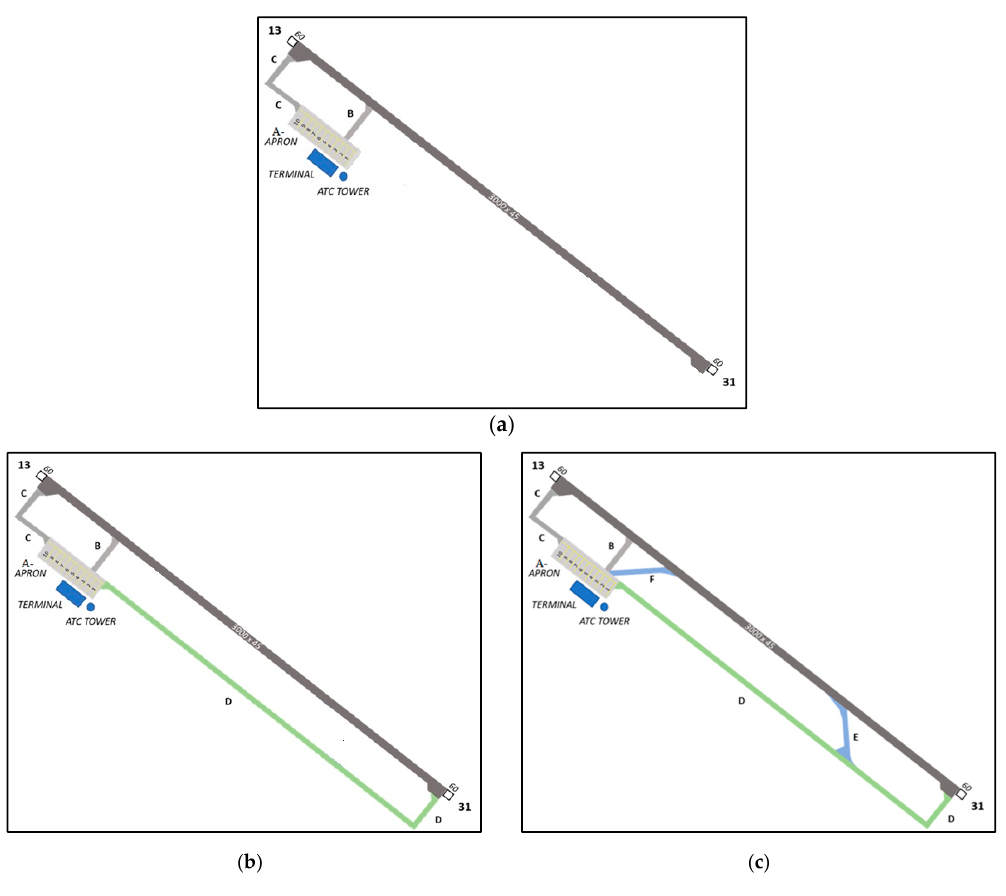
Figure 4. ( a ) U-turn, ( b ) Parallel, ( c ) Rapid exit.